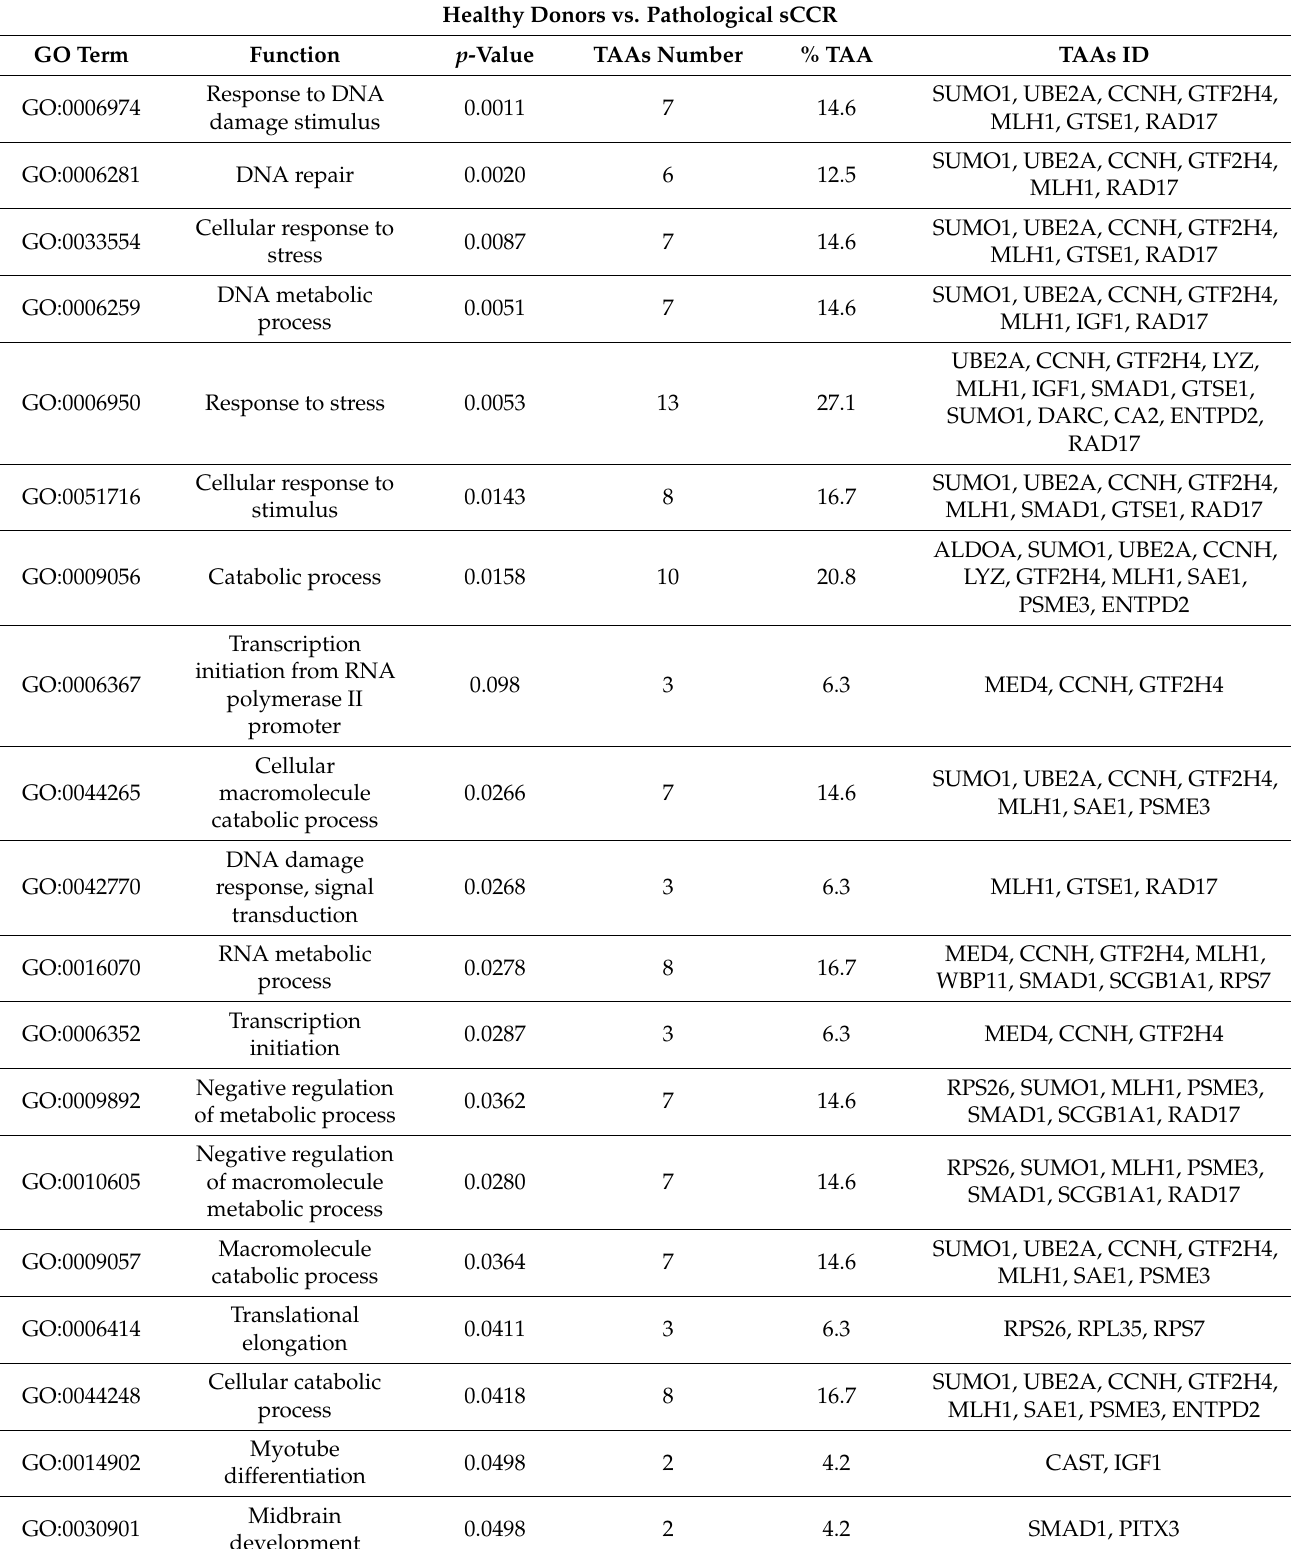
Table 4. Functional Enrichment Analysis of detected TAAs with statistical significance ( p > 0.05) between healthy donors vs. sCRC; non-metastatic sCRC vs. synchronic metastasis